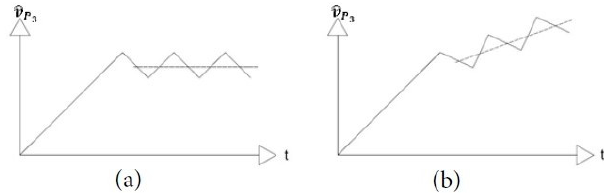
Figure 6. Time displacement diagrams: shakedown ( a ) and ratcheting ( b ).